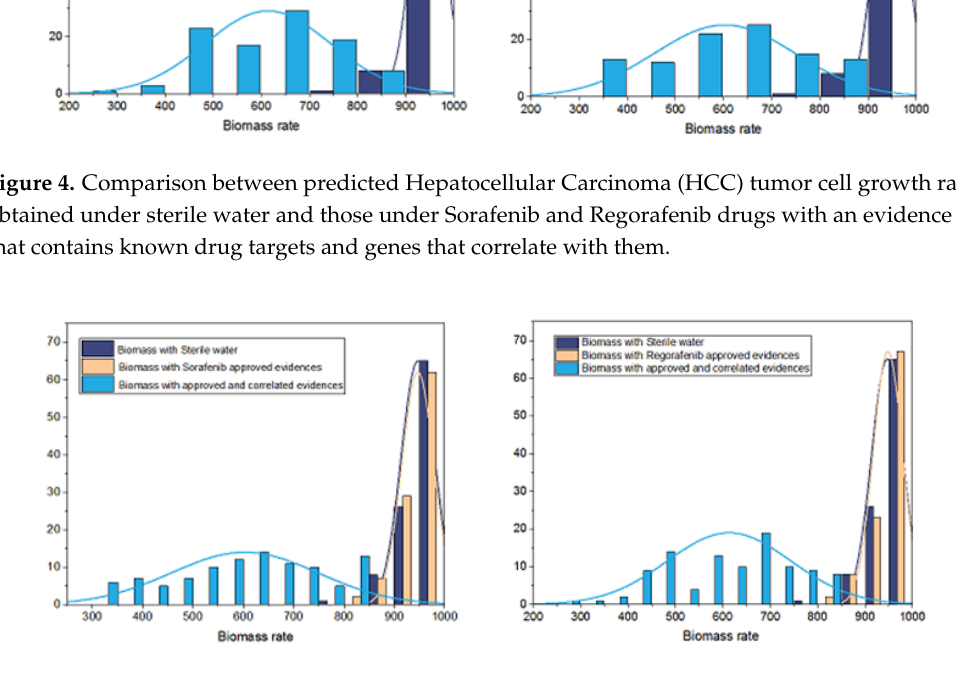
Figure 5. Comparison between predicted HCC tumor cell growth rates obtained under sterile water, those under Sorafenib and Regorafenib drugs with an evidence set that contains known drugs targets and genes that correlated with them, and those predicted with only known drug genes